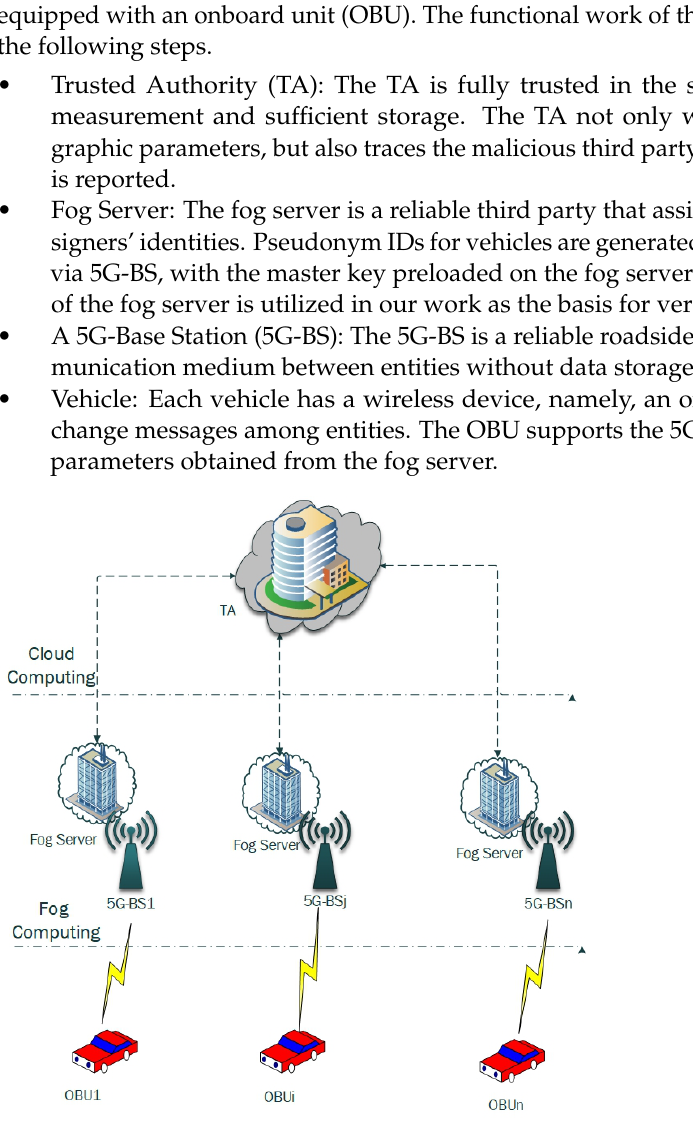
Figure 1. Design model of the proposed ANAA-Fog